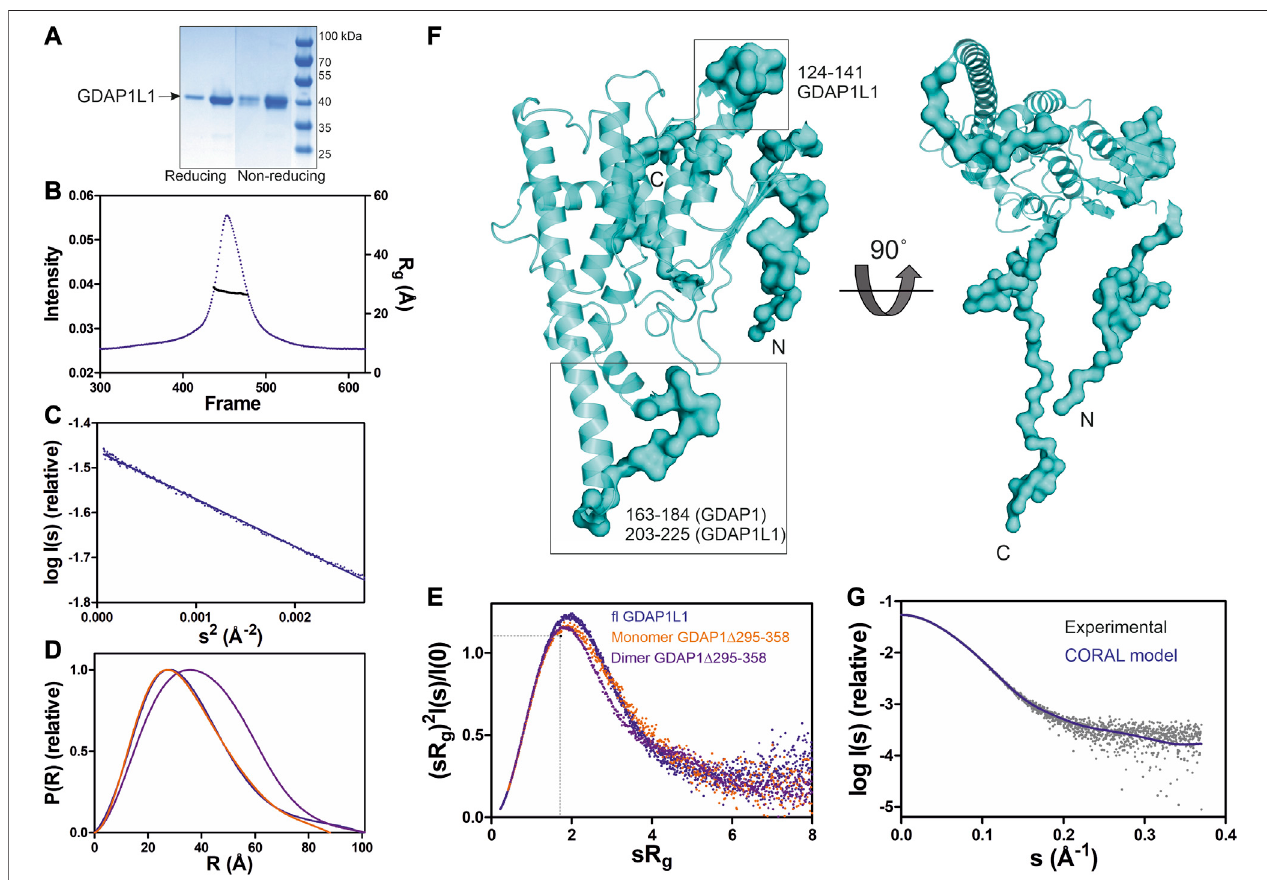
FIGURE7| SAXSanalysisofGDAP1L1. (A) NonreducingandreducingSDS-PAGEgelofGDAP1L1. (B) SEC-SAXSelutionpro fi leandR g plotofSAXSframes. (C) Guinier analysis. (D) Distance distributions p(r) plots. (E) Dimensionless Kratky plots for GDAP1L1 (blue) and GDAP1 monomer (orange) and dimer (purple). The dashed lines represent the peak position for a standard globular protein. (F) CORAL model of GDAP1L1 based on GDAP1 crystal structure (cartoon), surface for the restored missing fragments. (G) Experimental scattering curve of GDAP1L1 (grey) overlaid with the CORAL model (blue, χ 2 (cid:2) 1.19) using